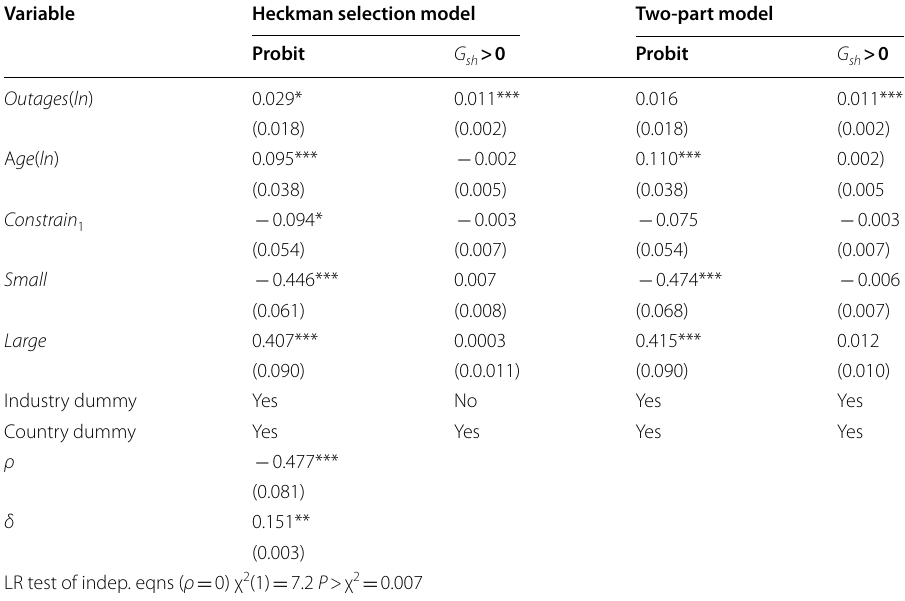
Table 5 Credit constraint and